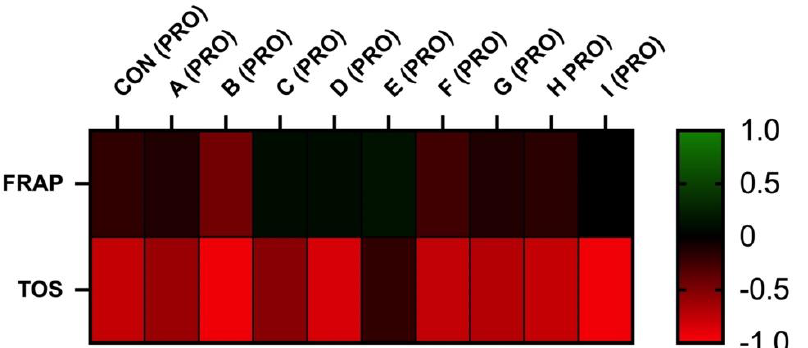
Figure 6. Correlations FRAP vs. PRO and TOS vs. PRO after 30 h of incubation at 5 °C ( n = 10): correlations between FRAP and MOT were determined by comparison of respective experimental concentrations (FRAP (CON) vs. PRO (CON), FRAP (A) vs. PRO (A), FRAP (B) vs. PRO (B), FRAP (C) vs. PRO (C), FRAP (D) vs. PRO (D), FRAP (E) vs. PRO (E), FRAP (F) vs. PRO (F), FRAP (G) vs. PRO (G), FRAP (H) vs. PRO (H), and FRAP (I) vs. PRO (I)), correlations between TOS and PRO were determined by comparison of respective experimental concentrations (TOS (CON) vs. PRO (CON), TOS (A) vs. PRO (A), TOS (B) vs. PRO (B), TOS (C) vs. PRO (C), TOS (D) vs. PRO (D), TOS (E) vs. PRO (E), TOS (F) vs. PRO (F), TOS (G) vs. PRO (G), TOS (H) vs. PRO (H), and TOS (I) vs. PRO (I)).